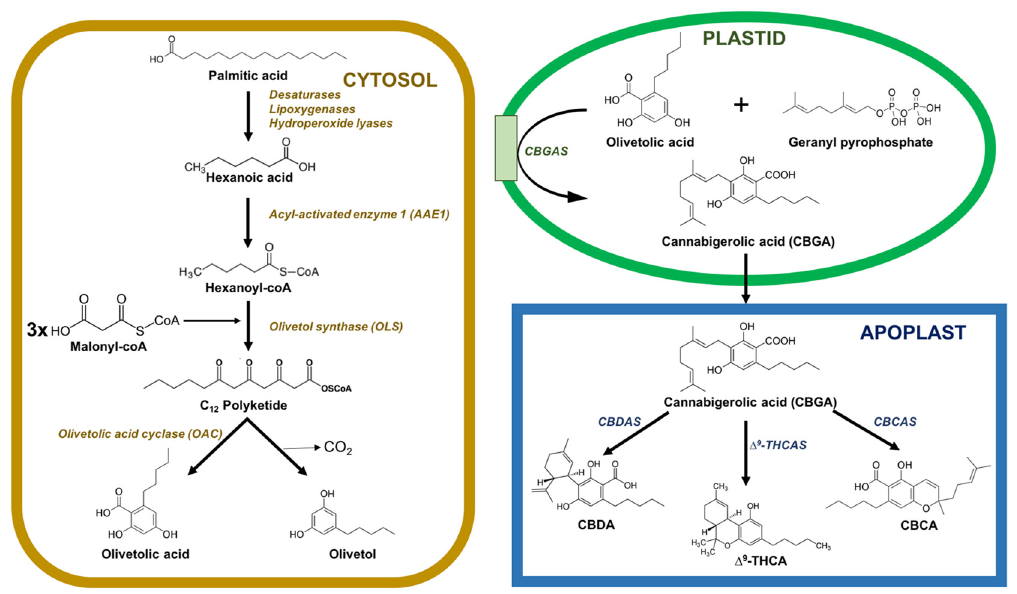
Figure 1. Subcellular distribution of enzymes catalyzing phytocannabinoid biosynthesis in C. sativa . Enzymes are located on the cytosol (yellow), plastids (green), or in the apoplastic space (blue). Abbreviations: CBCA, cannabichromenic acid; CBCAS, cannabichromenic acid synthase; CBDA, cannabidiolic acid; CBDAS, cannabidiolic acid synthase; CBGAS, cannabigerolic acid synthase; ∆ 9 -THCA, ∆ 9 -tetrahydrocannabinolic acid; ∆ 9 -THCAS, ∆ 9 -tetrahydrocannabinolic acid